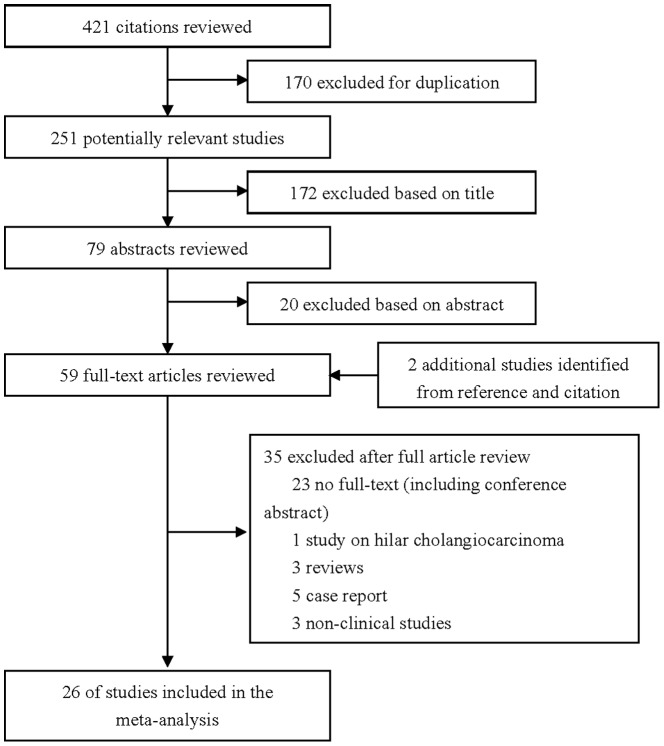
Search flow diagram for studies included in the meta-analysis.